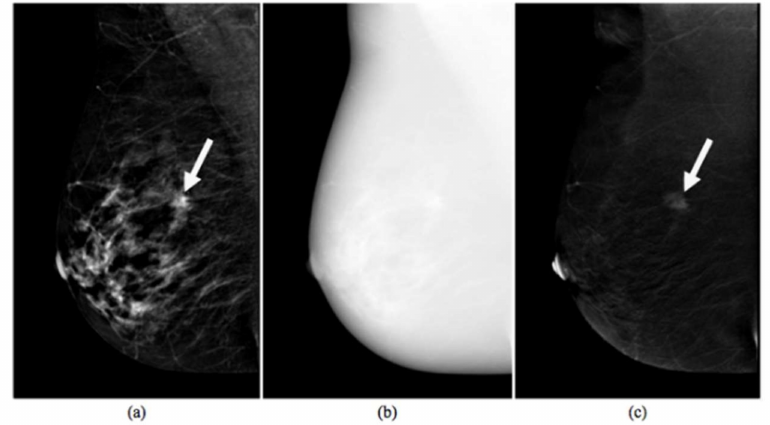
Figure 1. Images produced by Contrast-Enhanced Spectral Mammography (CESM) instrument. Typical example of low-energy ( a ), high-energy ( b ) and recombined ( c ) images [5]. The white arrow points to a suspicious